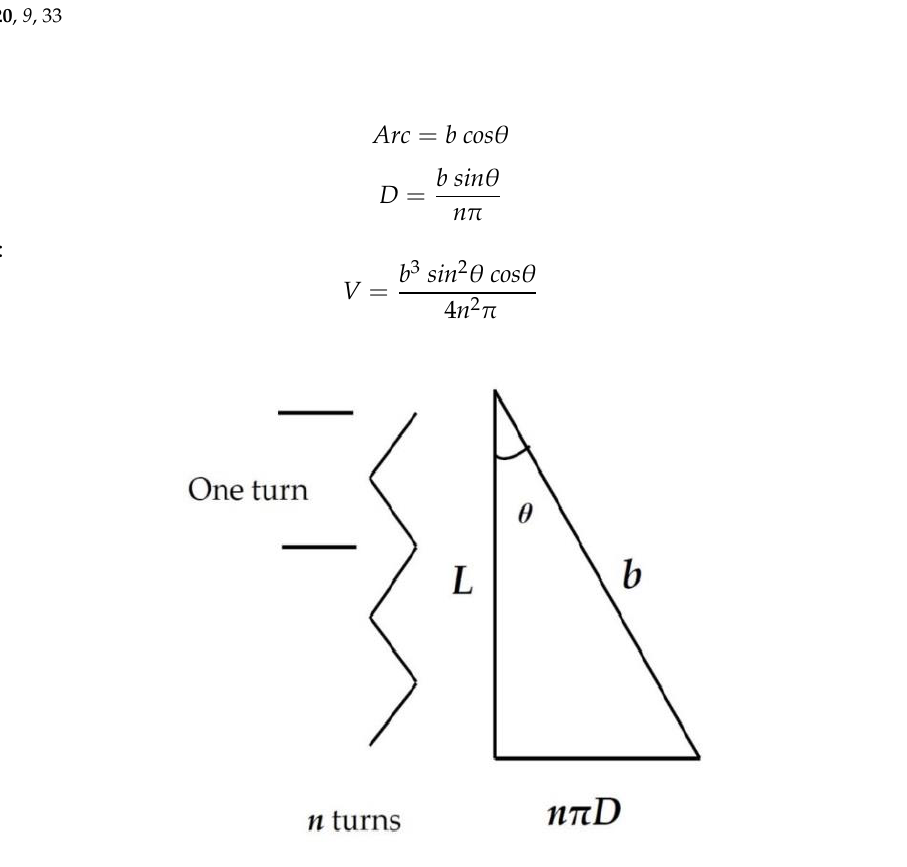
Figure 8. The parameters of the PMA.